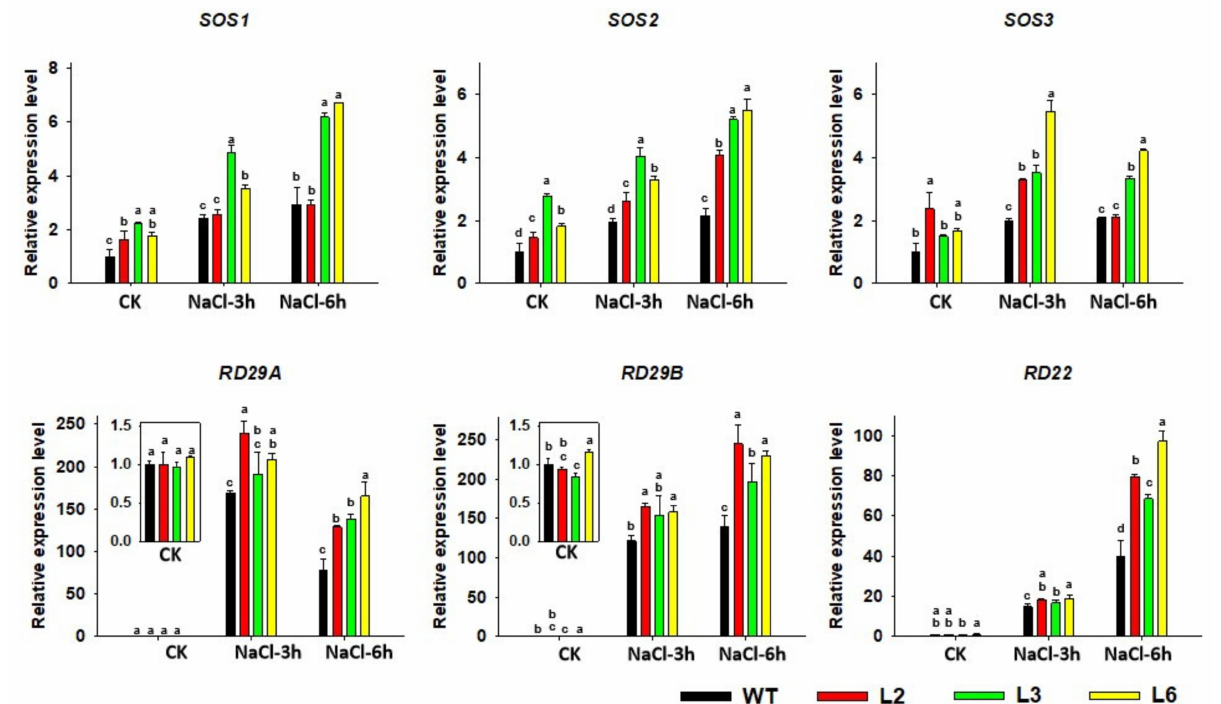
Figure 7. Expression of salt-responsive genes in TaRAV1 transgenic Arabidopsis. The 7-day-old seedlings of WT and 3 transgenic lines (L2, L3, L6) were treated with 150 mM NaCl for 3 and 6 h. Transcript levels of selected genes were quantified using the qRT-PCR method, and normalized to Atactin mRNA. The transcript levels of WT under control condition (CK) were set to 1. Data shown are means ± SE (n = 3). Different letters represent significant differences ( p < 0.05, one-way